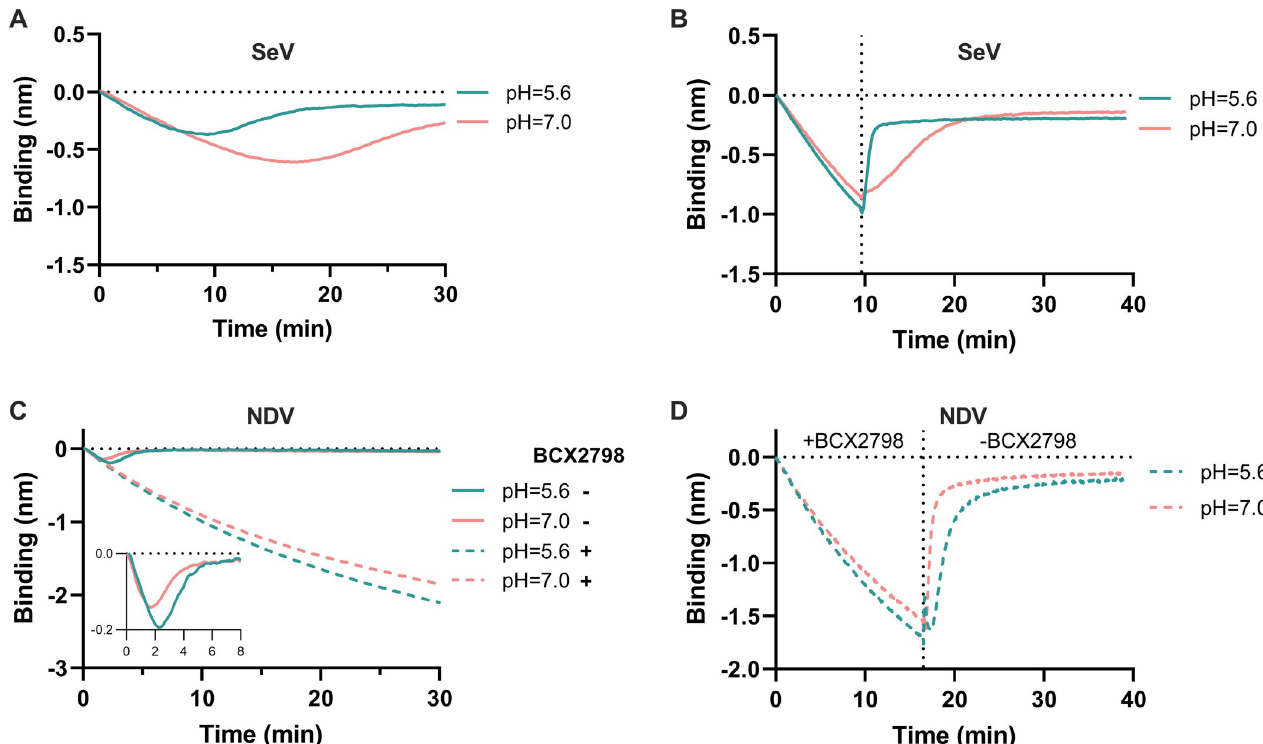
Fig 10. pH effect in SeV and NDV association and dissociation to 3’S(LN) 2 -PAA. (A) 3’S(LN) 2 -PAA-loaded sensors were incubated with SeV at pH5.6 or 7.0 for 30 min. ( B) 3’S(LN) 2 -PAA-loaded sensors were incubated at pH 5.6 or 7.0 with SeV after which sensors were incubated at pH 5.6 or 7.0 in the absence of free virions. (C) 3’S(LN) 2 -PAA-loaded sensors were incubated with NDV at pH5.6 or 7.0 in the absence or presence of BCX2798. (D) 3’S(LN) 2 -PAA-loaded sensors were incubated with NDV at pH5.6 or 7.0 in the presence of BCX2798. Subsequently, sensors incubated in the absence of BCX2798, allowing sialidase- driven virion dissociation from the